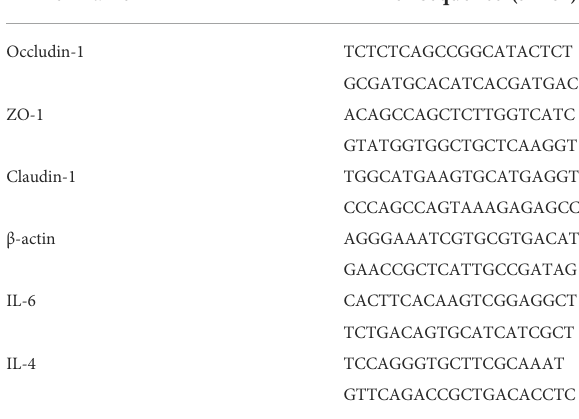
TABLE 1 Designed primer